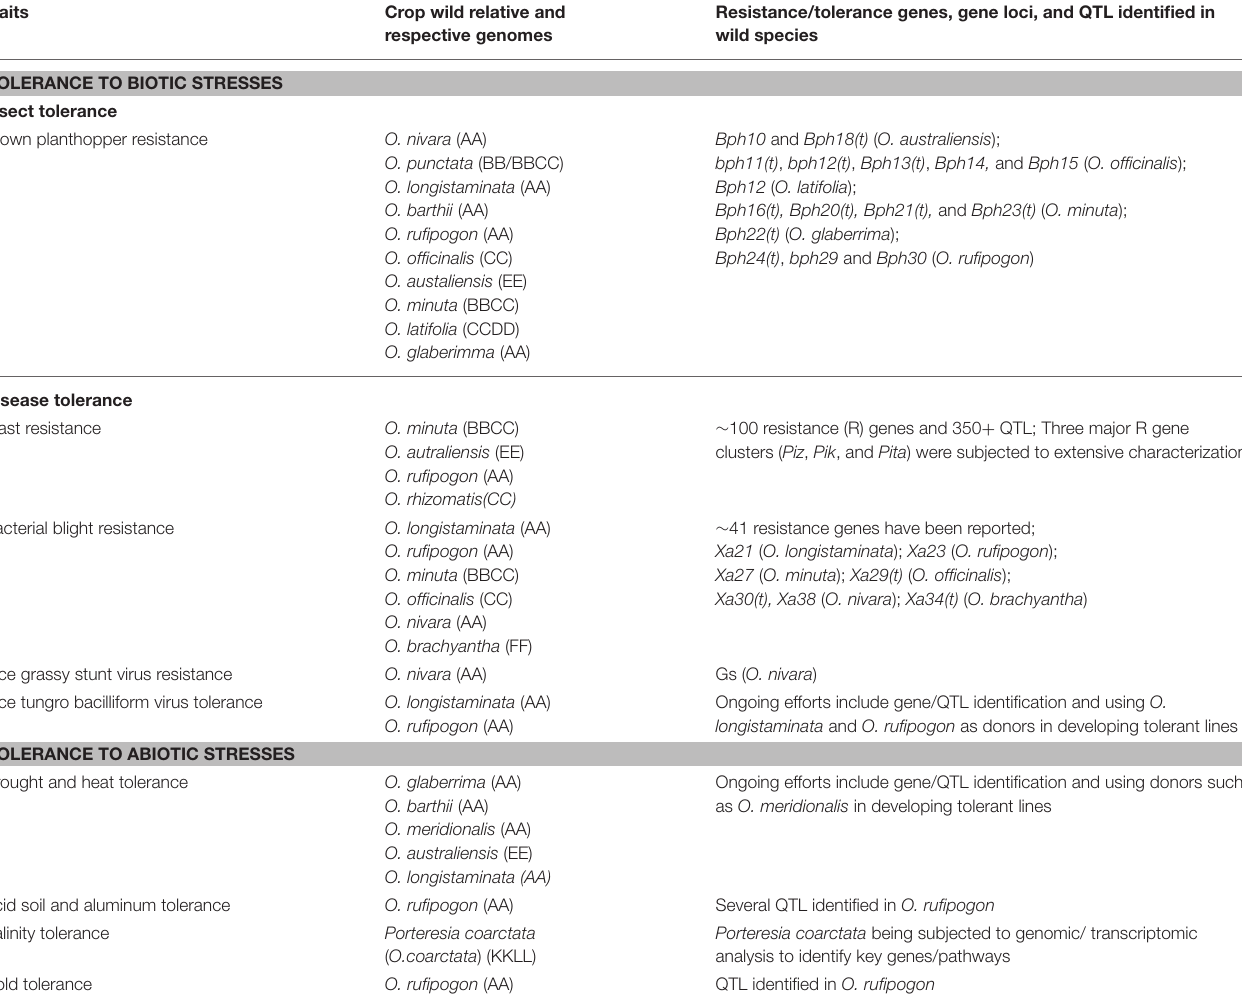
TABLE 2 | Summary of biotic and abiotic stress tolerance traits of wild relatives of rice ( Oryza sativa ). Traits Crop wild relative and respective